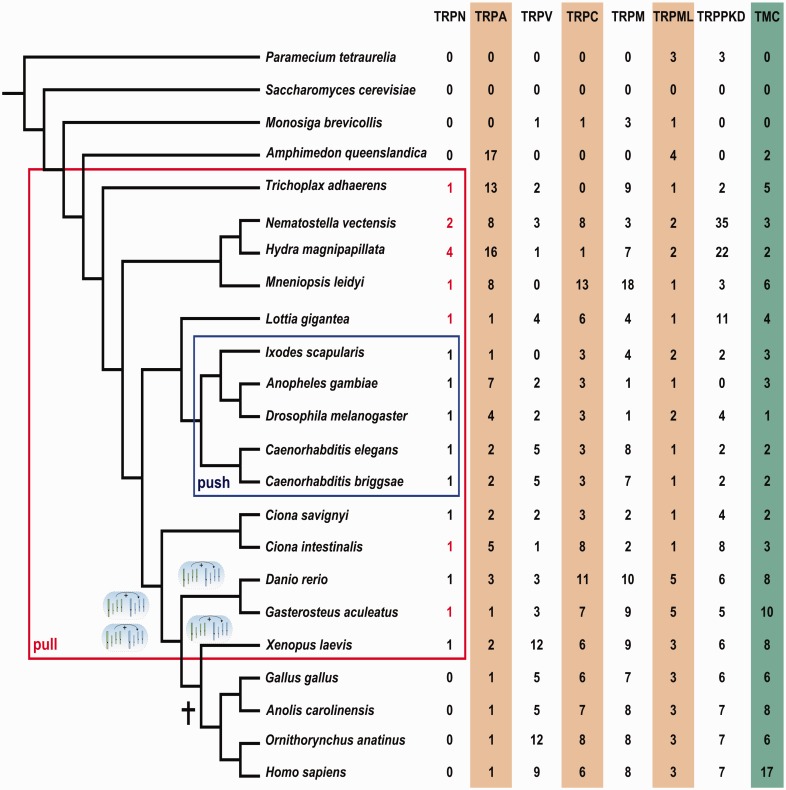
Phylogenetic distribution of transient receptor potential (TRP) families across Metazoa. The sizes of TRP subfamilies which were found using custom-made HMMs are listed at the tips of a phylogenetic tree for a representative set of metazoan genomes which were used (see Materials and Methods for a complete set of used genomes and supplementary fig. S4, Supplementary Material online, for corresponding phylogeny and occurrences of TRP-N). The tree topology is based on Philippe et al. (2011). Presumed events of WGDs are indicated by blue ellipses. Red frame encloses genomes in which TRP-N could be identified. Blue frame indicates TRP-N proteins which are activated through a “push,” mechanism (see text for explanations). Cross indicates the point at which the only bilaterian TRP-N copy has most likely been lost, that is, at the root of amniotes. TRP-N proteins with manually curated (in this study) gene models are in bold, and genes that were resequenced and PCR confirmed for this study are in red.